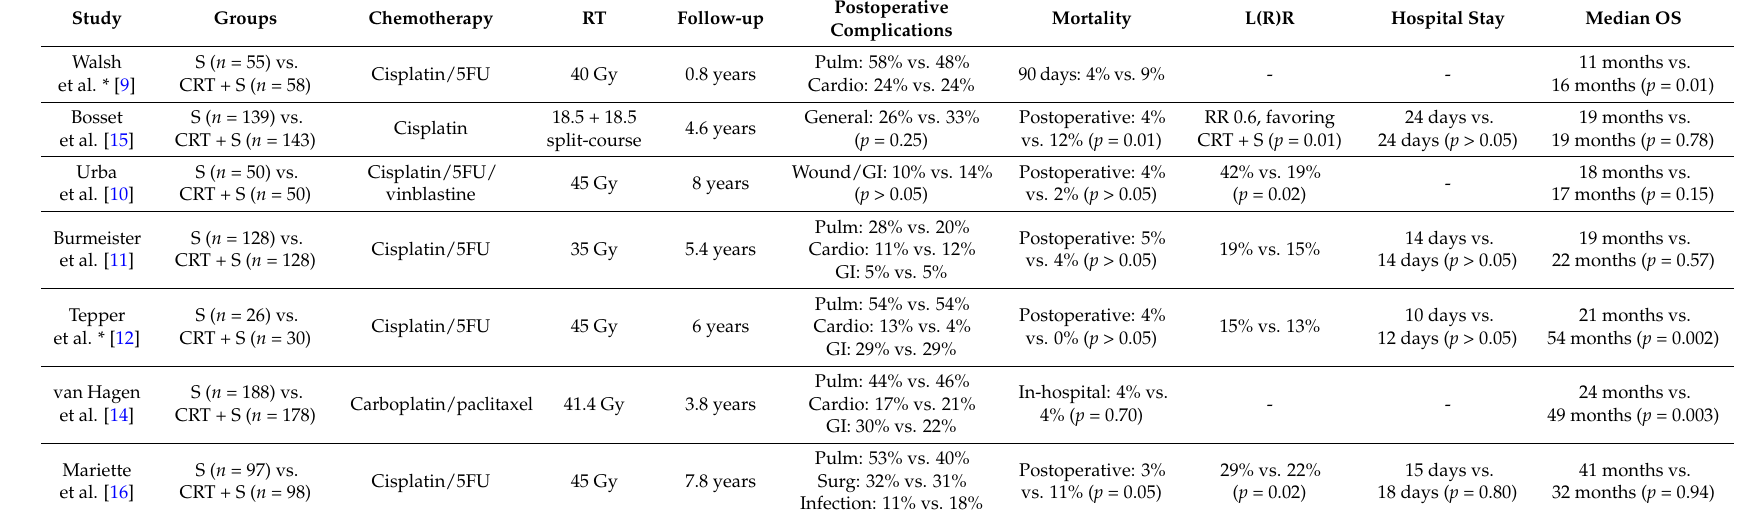
Table 1. Selected randomized trials examining neoadjuvant chemoradiation followed by surgery versus surgery alone.